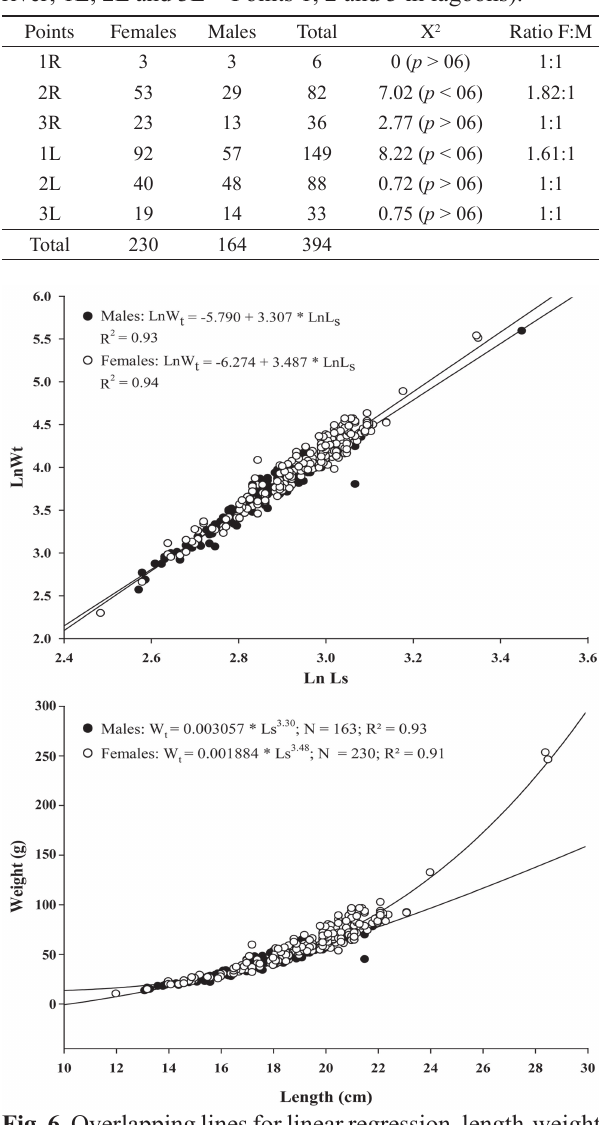
Fig. 6. Overlapping lines for linear regression, length-weight relationship and their respective equations between separate sexes of Loricariichthys melanocheilus in the rio Ibicuí, Rio Grande do